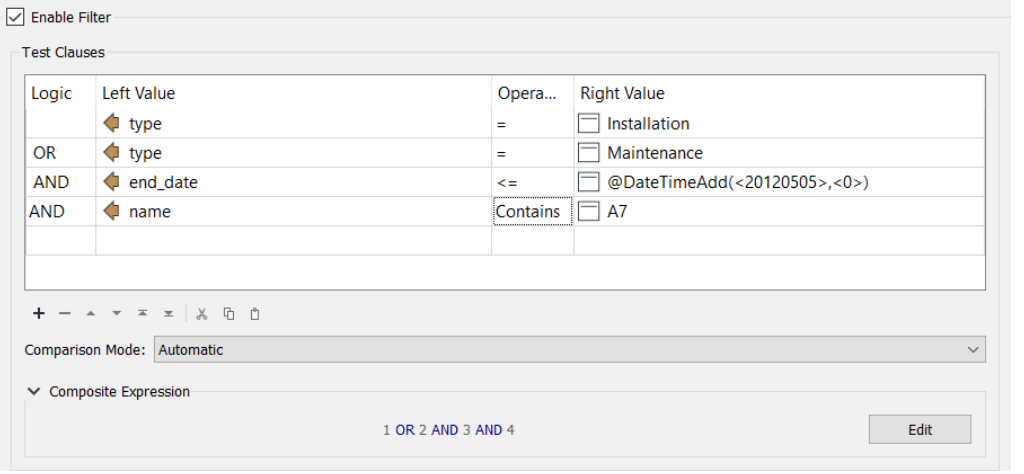
Figure 11. Example of analysis filter applied to the Highway Information Model.